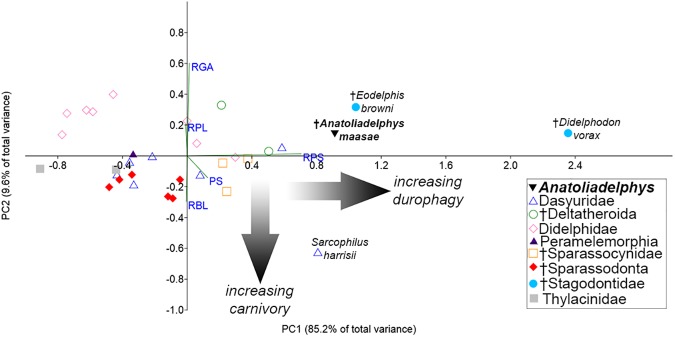
Principal component analysis of five morphofunctional dental indices for Anatoliadelphys maasae and other carnivorously-adapted metatherians.The morphofunctional dental indices used were Relative Grinding Area (RGA), Relative Premolar Size (RPS), Premolar Size (PS), Relative Premolar Length (RPL) and Relative Blade Length (RBL). The plot shows the first two principal components (PCs) only.